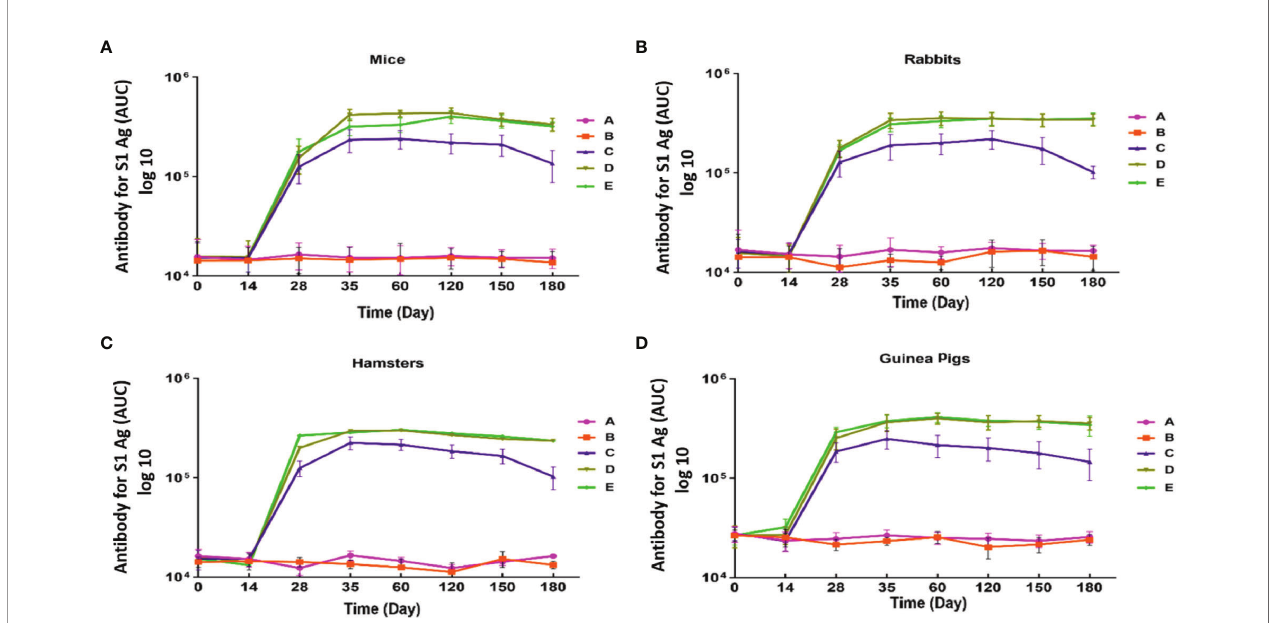
FIGURE 2 | Anti-SARS-CoV-2 immunoglobulin-G (IgG) antibody titers against S1 antigen in different animal models immunized with candidate vaccine. (A) Anti-SARS-CoV-2 immunoglobulin-G (IgG) antibody titers against S antigen for 180 days from the day it is received candidate vaccine in mice. (B) Anti-SARS-CoV-2 immunoglobulin-G (IgG) antibody titers against S1 antigen for 180 days from the day it is received candidate vaccine in rabbit. (C) Anti-SARS-CoV-2 immunoglobulin-G (IgG) antibody titers against S1 antigen from 1st to 180 day of immunization with candidate vaccine in hamster. (D) Anti-SARS-CoV-2 immunoglobulin-G (IgG) antibody titers against S antigen for 180 days from the day it is received candidate vaccine in in Pirbright guinea pig. Data are presented as mean ± standard deviation (SD). The levels of statistical signi fi cance for differences between test groups were determined using one-way ANOVA followed by Tukey ’ s post hoc test. Statistical comparison was done by comparing the vaccinated group with the placebo group as a control. All animal groups receiving candidate vaccine (low, middle, and high dose) showed a statistically signi fi cant difference of IgG antibody in compared with the groups receiving placebo and adjuvant (P<0.001) on days 28, 35, 120 and 180. Placebo (adjutant of RAS-01) (group A), phosphate buffered saline (PBS, group B), low dose candidate vaccine (group C), middle dose candidate vaccine (group D), and high dose candidate vaccine (group